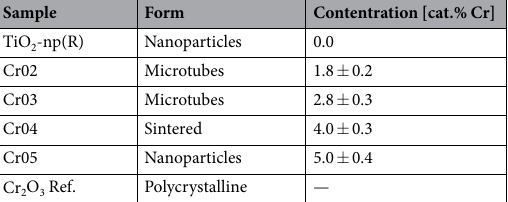
Table 1. List of samples and corresponding Cr concentration in cationic fraction respect to Ti quantified by